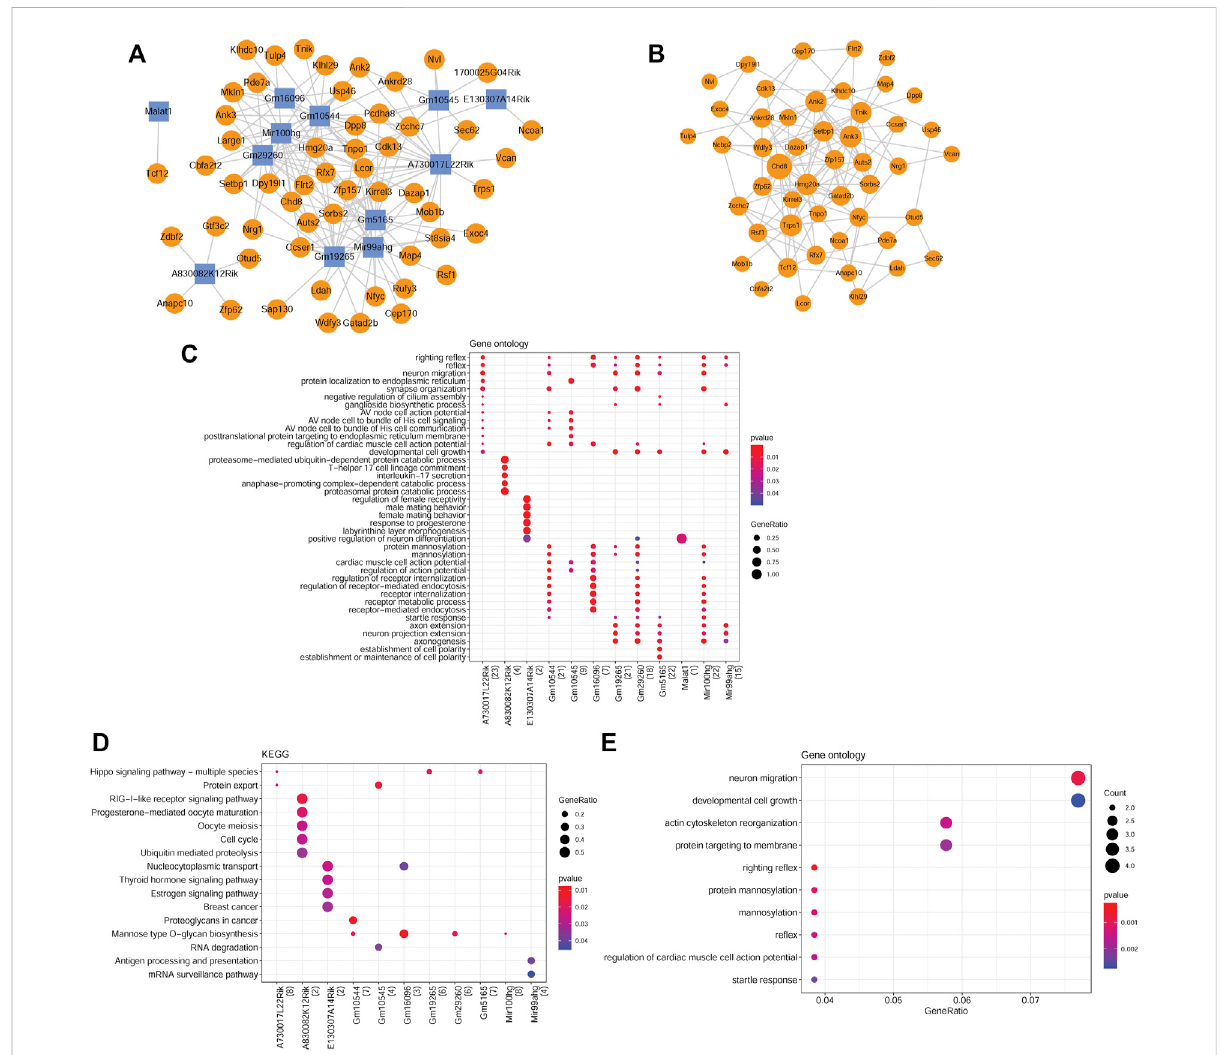
FIGURE 4 Analysis of co-expressed DElncRNAs and DEGs. (A) lncRNA-mRNA co-expression network. Yellow circles represent downregulated mRNAs. Blue squares represent downregulated lncRNAs. (B) PPI network constructed by co-expressed DEGs. (C) GO-BP terms enriched by co-expressed DElncRNAs. (D) KEGG pathways enriched by co-expressed DElncRNAs. (E) GO-BP terms enriched by co-expressed DEGs. The size of a node corresponds to the size of the